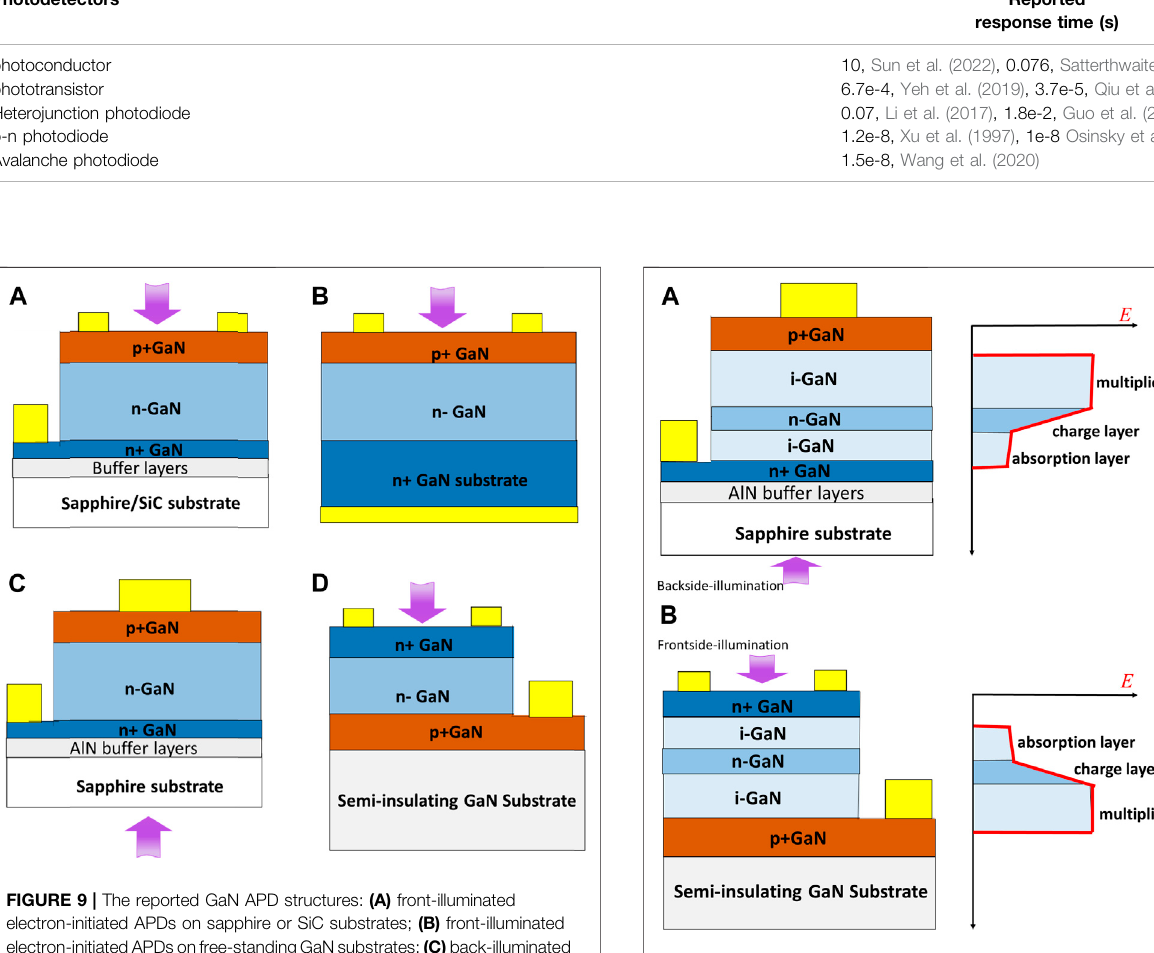
FIGURE 10 | (A) The separated absorption and multiplication (SAM) structurebasedonGaN-on-Sapphire(left)andthecorrespondingelectric fi eld distribution along the vertical direction (right). (B) the proposed SAM structure based on GaN-on-GaN (left) and the corresponding electric fi eld along the vertical direction